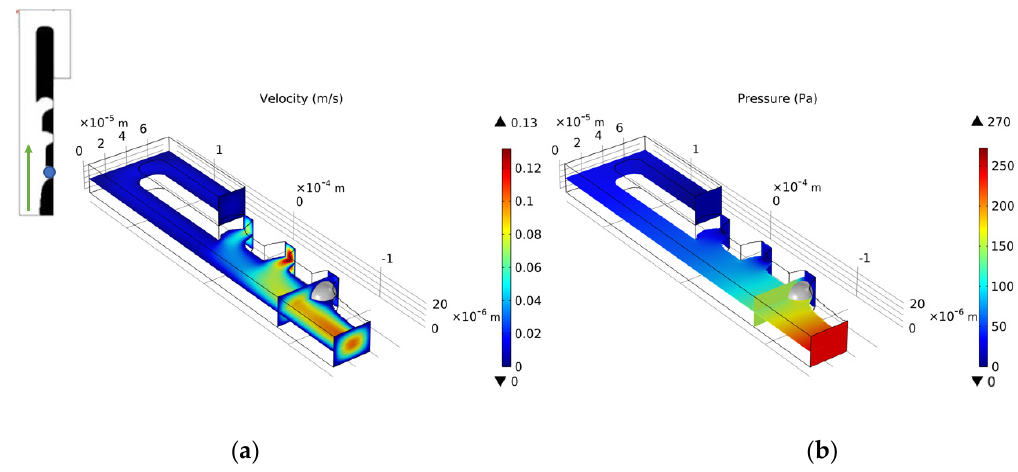
Micromachines 2021 , 12 , x FOR PEER REVIEW Figure 13. ( a ) The velocity field distribution and ( b ) pressure field distribution of 3D model with one captured cell.